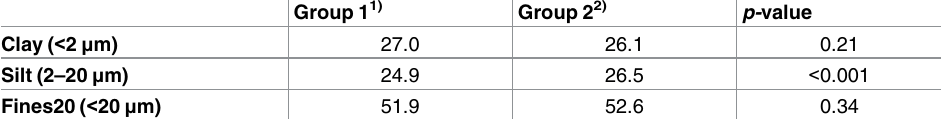
Table 1. Average values (g 100 g -1 minerals) of clay, silt and Fines20 for hydrogen peroxide treated soils from Group 1 and Group 2 at Highfield. P-values for testing differencesbetweenthe two groups are indicatedand were calculatedby a